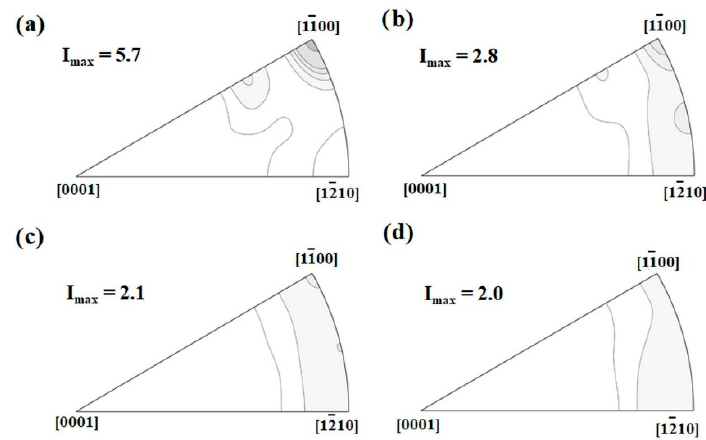
Figure 2. Inverse pole figures of the extruded alloy in initial as-extruded condition obtained by X-ray diffraction: ( a ) ZX10-04, ( b ) ZX10-11, ( c ) ZX10-23, ( d ) ZX10-53. The contour levels are 1, 1.5, 2, 3, 5, 7 m.r.d. (multiples of a random distribution).